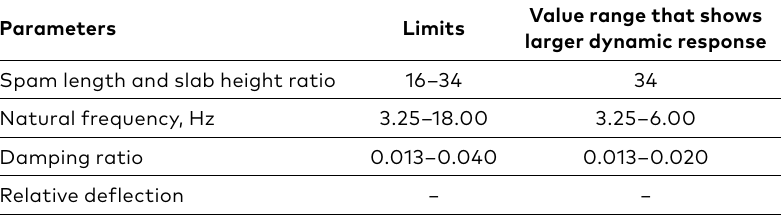
Table 1. Values which indicate increased dynamic reaction for reinforced concrete slab